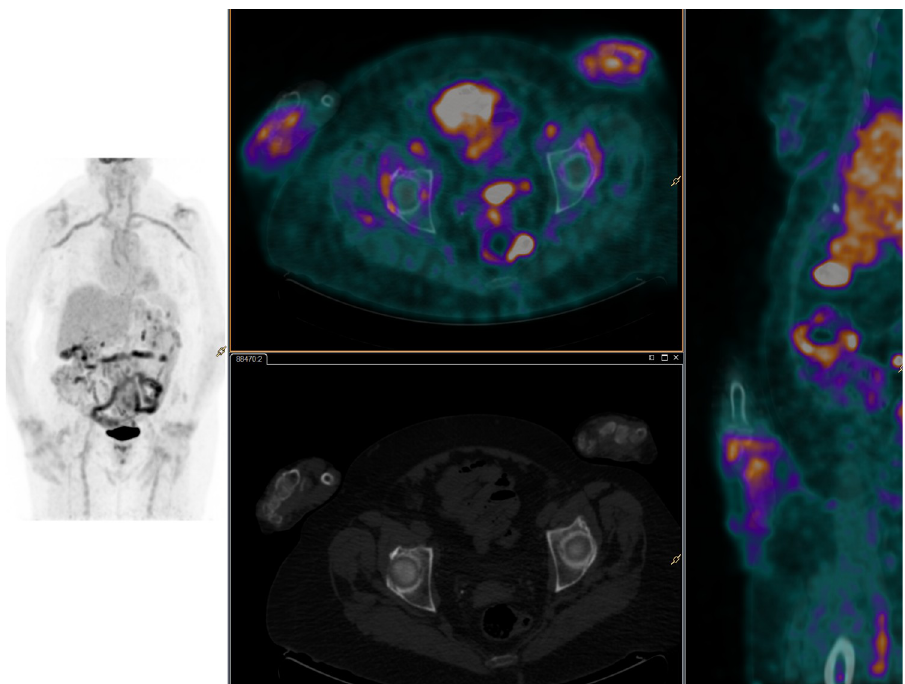
Fig 1. 18 FDG-PET/CT images. A 78-year-old woman with diagnostic of elderly onset rheumatoid arthritis [EORA]. Fused 18F-FDG PET/CT and MIP images showed increased metabolism in aortic wall and supraortic vessels which corresponded to vasculitis. Increased 18F-FDG uptake in peripheral joints was also described with shoulder involvement. Inflammatory activity in the wrists was also observed, as a characteristic arthritis in this pathology. https://doi.org/10.1371/journal.pone.0255131.g001 bursa (Fig 2). Of the 23 patients with joint uptake in the 18 FDG-PET/CT scan, the area most frequently affected was the sternoclavicular (23.28%), followed by the knees (10.95%) and the wrist (8.21%). Of the 16 patients diagnosed with LVV, in addition to glucidic uptake increase in the aortic wall, 18 FDG PET/CT scans showed a concomitant uptake in the shoulders, hips and bursae. We did not measure vascular diameters in the patients with PMR included in the study. Never- theless, in the visual evaluation, we did not observe dilated vessels. Table 3 shows the sites of 18 FDG accumulations in patients with PMR and LVV.